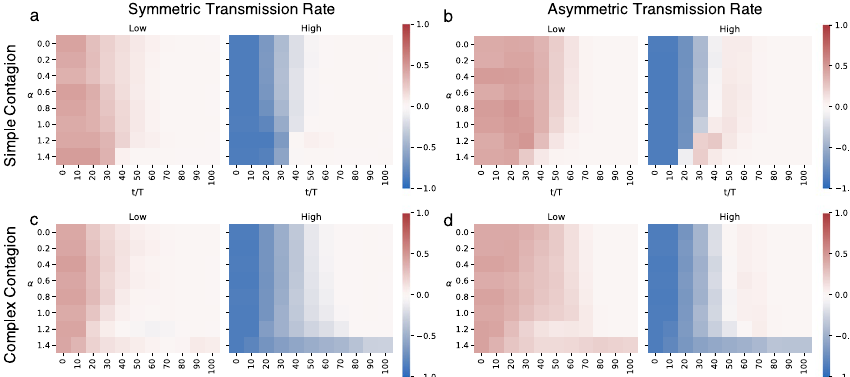
Fig. 4 Information spreading equality for homophily BA with different preferential attachment strengths α . When α < 1 , we observe few differences in information equality, implying that for sublinear preferential attachment, other factors such as homophily are more important for information access equality. However, for α ≥ 1 (which is often the case in real‑world networks), the type of contagion is important. For example when α = 1.4 , simple contagion achieves information access equality quickly (shown in a and b ). This is not true under complex contagion (shown in c and d ). This highlights the importance of the type of contagion on the